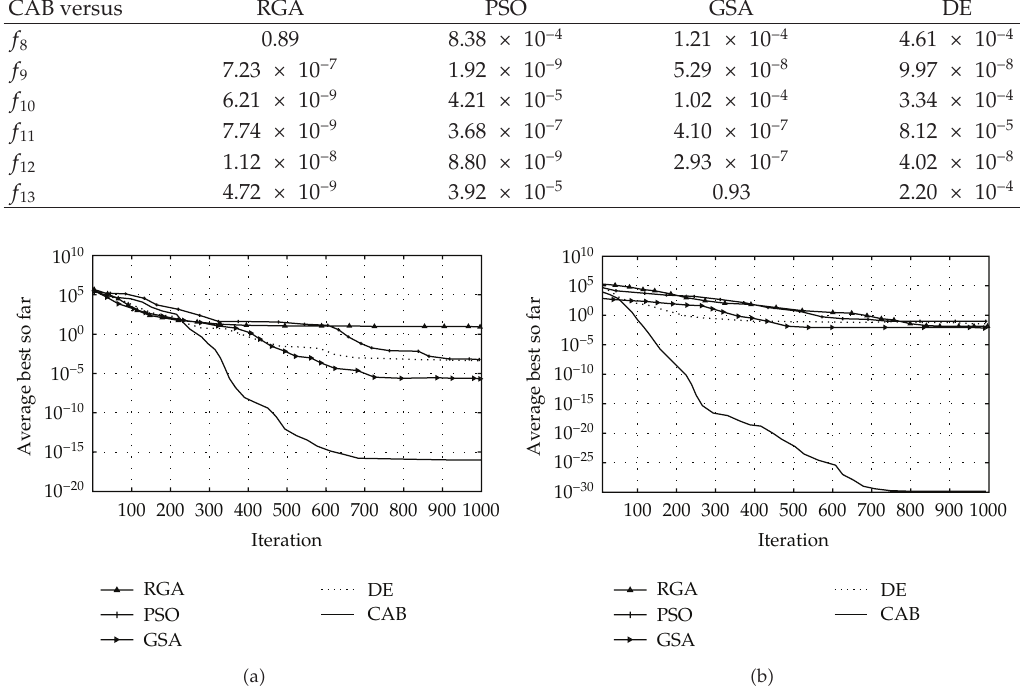
Figure 3: Performance comparison of RGA, PSO, GSA, DE, and CAB for minimization of (cid:2) a (cid:3) f 10 and (cid:2) b (cid:3) f 12 considering n (cid:8)